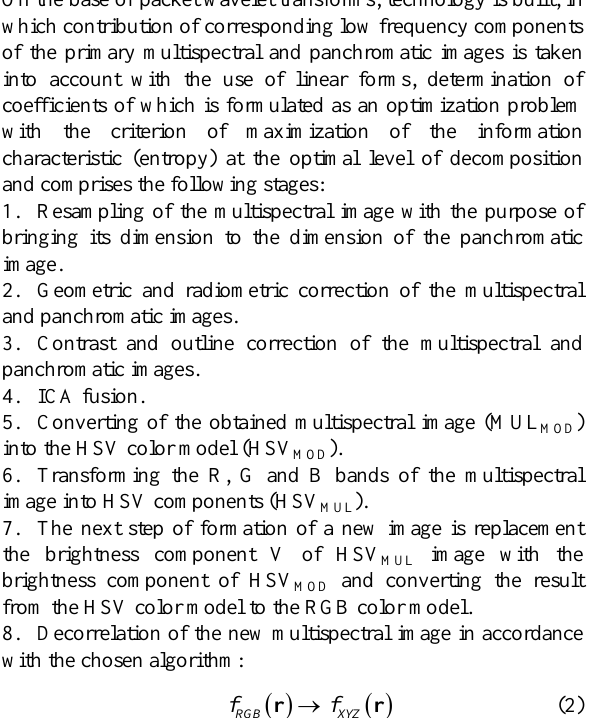
Figure 3. Algorithm